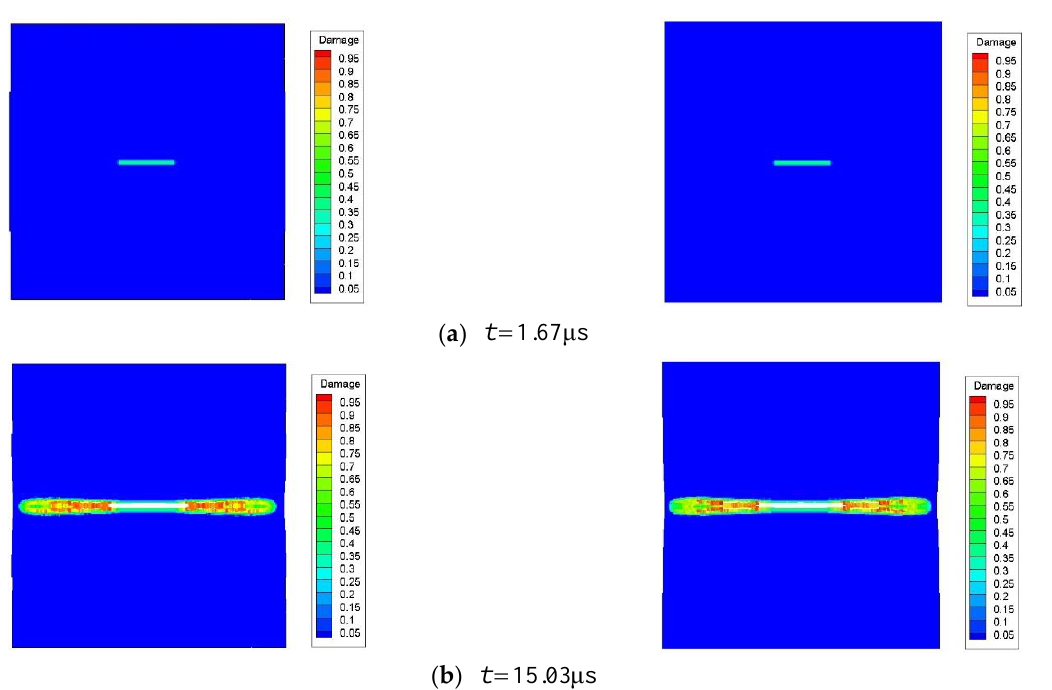
Figure 7. Crack propagation simulations, left : FEM-PD coupling model and right : PD model.